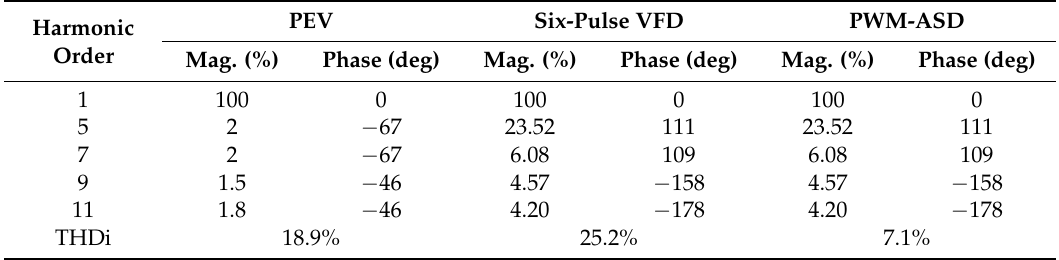
Table 1. Typical low order harmonic current spectrum of EV chargers and industry nonlinear loads [2,25].